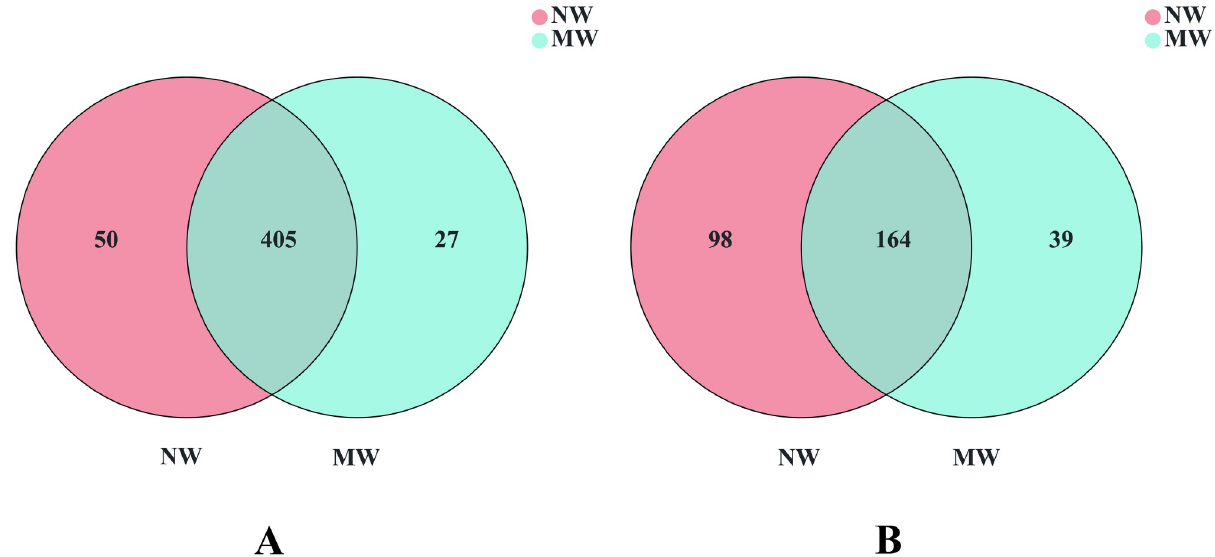
Fig 4. Venn Diagram of soil bacterial (A) and fungal (B) communities at genus level between the NW and MW treatments in star anise plantations. Note . NW: no weeding in the star anise plantation, and MW: mechanical weeding in the star anise